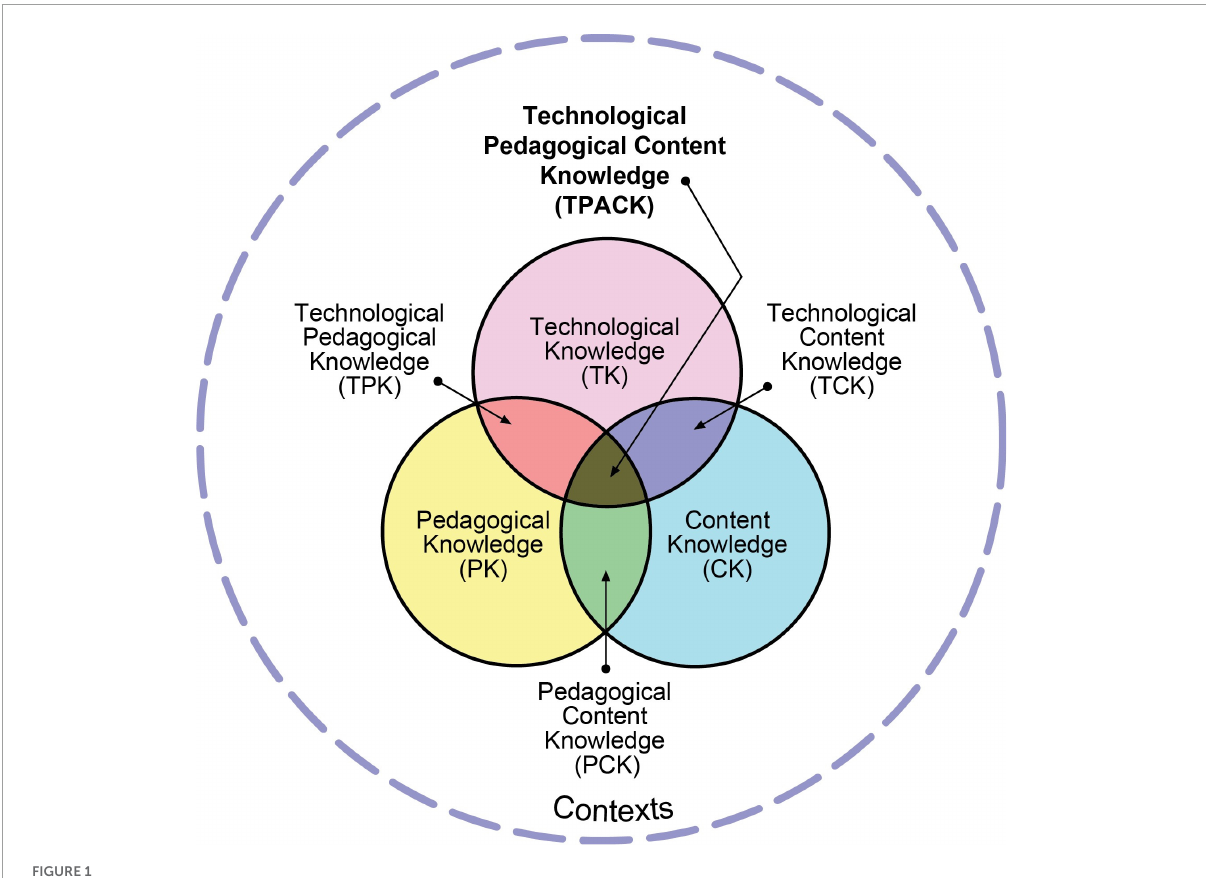
FIGURE1 Representation of